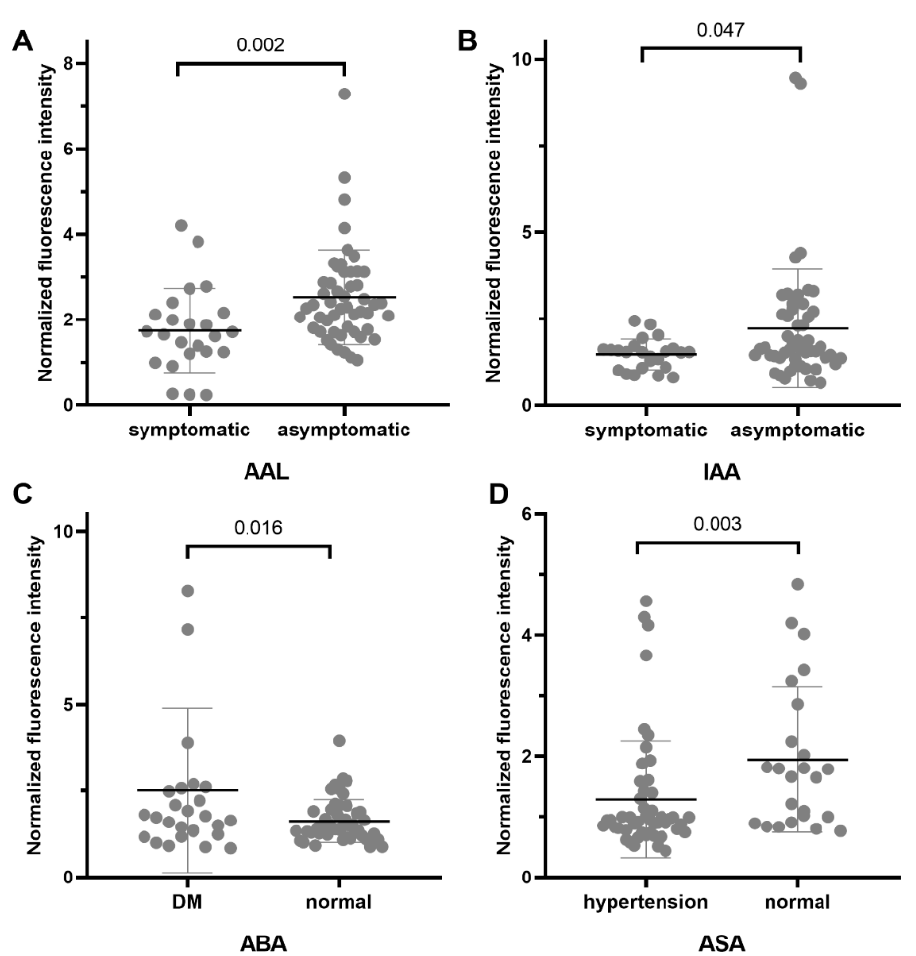
Figure 3. Positive results from lectin microarray for patients in different CAS subgroups. The following rules were used to identify significant differences for intra-disease group analysis: fold change[group1(S/N)/group2(S/N)] ≥ 1.75 or <0.571 and p -value < 0.05. DM, diabetes mellitus. Details of lectins and their binding glycan structures can be seen in the Supplementary Files. ( A ). Microarray result for AAL between symptomatic or asymptomatic CAS patients. ( B ). Microarray result for IAA between symptomatic or asymptomatic CAS patients. ( C ). Microarray result for ABA between CAS patients with or without diabetes ( D ). Microarray result for ASA between CAS patients with or without hyperntension.